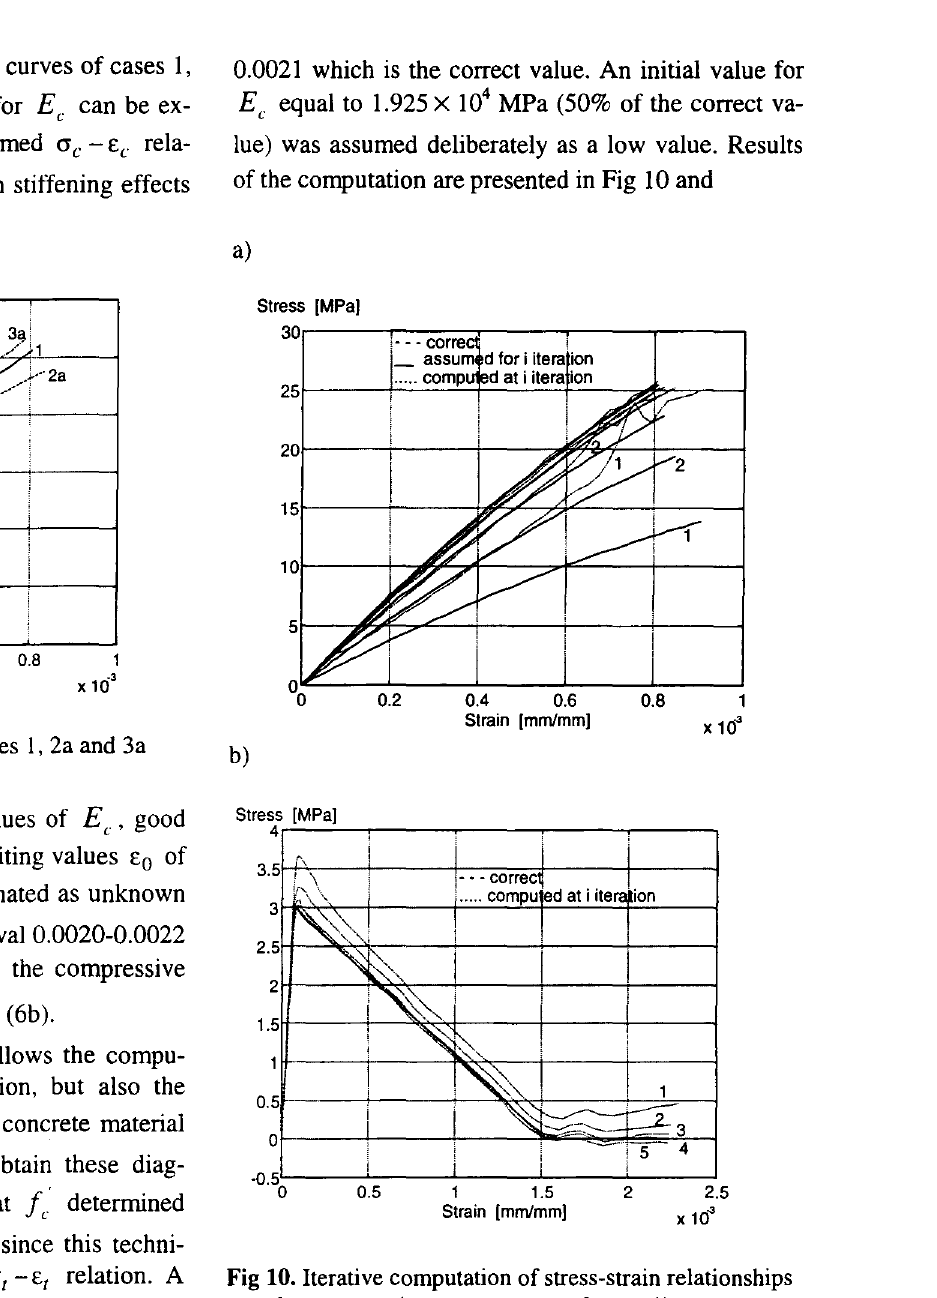
Fig 10. Iterative computation of stress-strain relationships (a)- for compressive concrete; (b)- for tensile concrete. 1, 2, 3, 4 and 5 - iteration number Table 2. Dashed lines in Fig 10 indicate the correct cr- E relationships both for tensile and compressive concrete which are expected to be approached in the iterative process. The computed cr- E relationship corresponding to iteration i is shown by a dotted cur ve. The assumed cr c - Ec relationship corresponding to iteration i is shown by a solid line in Fig 1 O(a). It can be seen from Fig 1 O(b) that three iterations were ne relationship which is very close to eded to get cr E 1 - 1 the correct one. The correct crc - Ec curve was reaso nably approached in four iterations (Fig 10(a)). Alt-